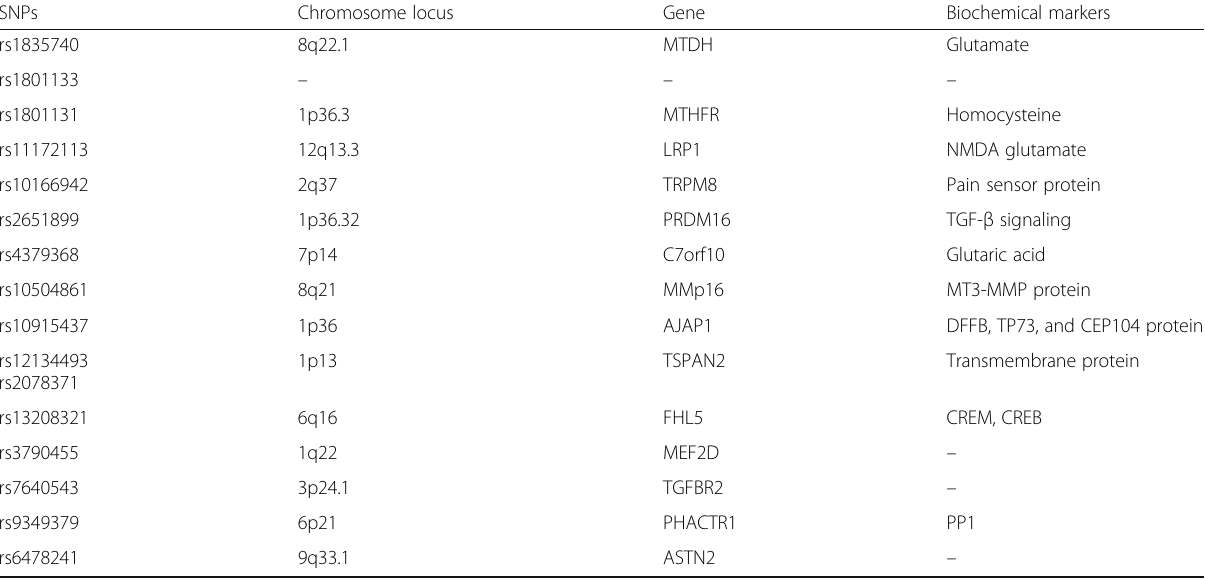
Table 2 Variants identified in common form of migraine and replicated in various studies SNPs Chromosome